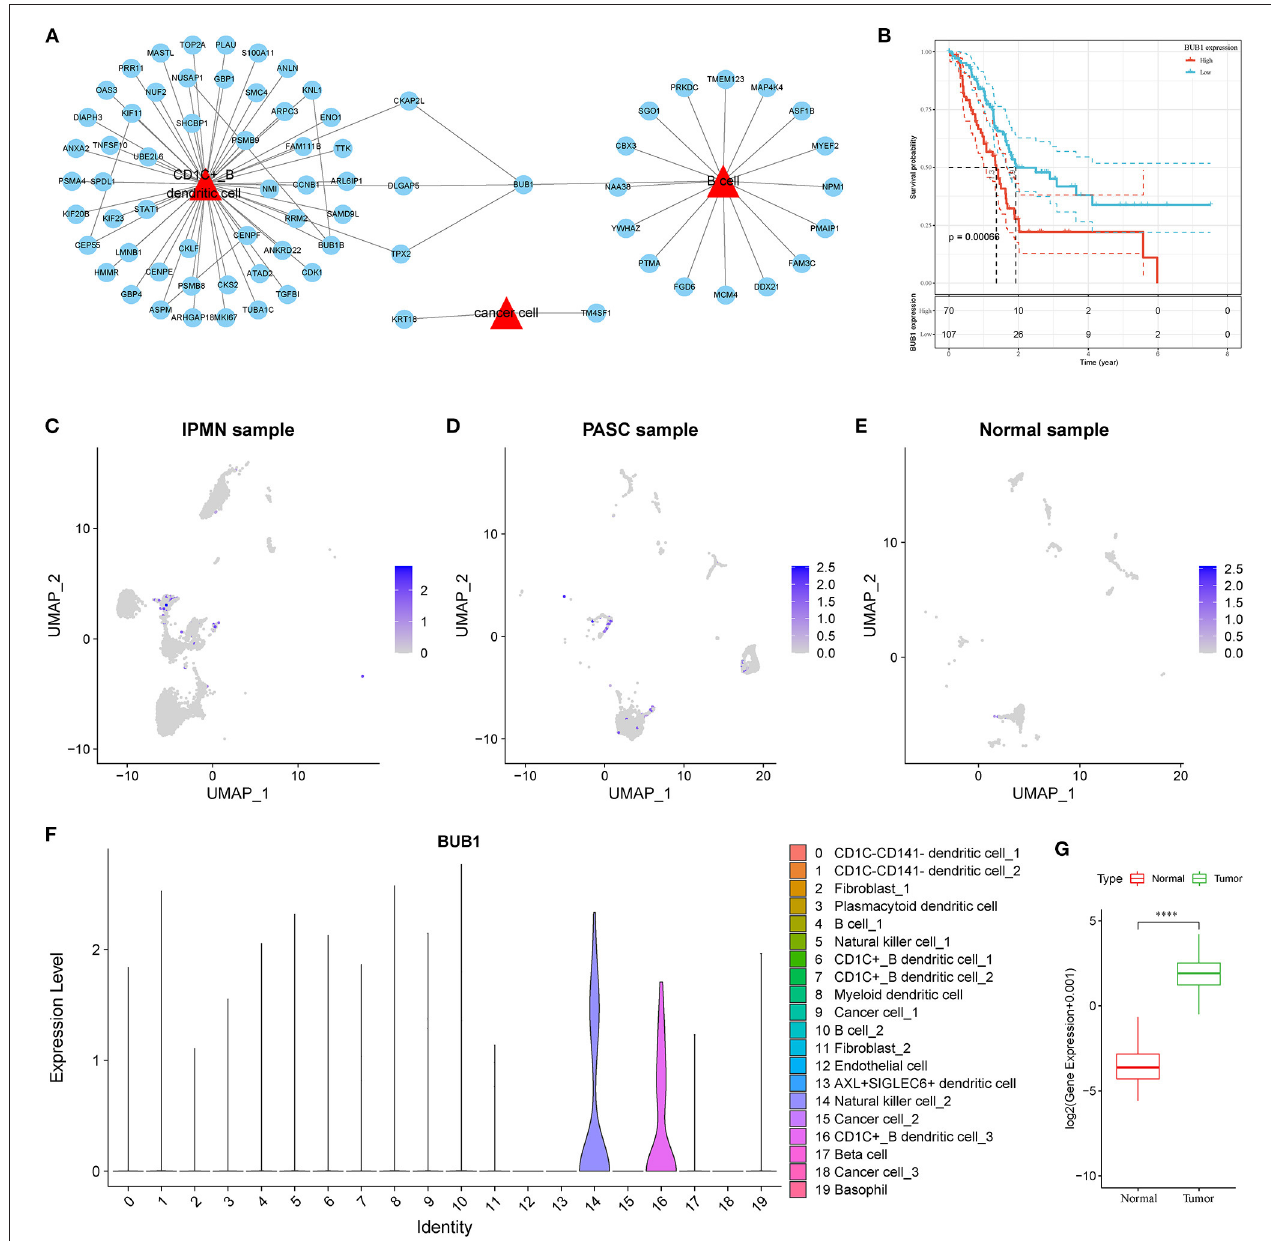
FIGURE 10 | Screening of hub genes highly contributing to cancer development. (A) A PPI network of marker genes of C4, C10, C16 and C18. Red triangle indicates cell types and blue circle indicates marker genes. (B) Kaplan–Meier survival plot of BUB1 grouped by high and low expression. (C–E) UMAP plots showing distribution and expression of BUB1 in IPMN, PASC and normal samples. Colors from gray to blue indicate expression from low to high. (F) Violin plot of BUB1 expression in 20 subtypes. (G) Difference in expression and distribution of BUB1 between cancer and normal